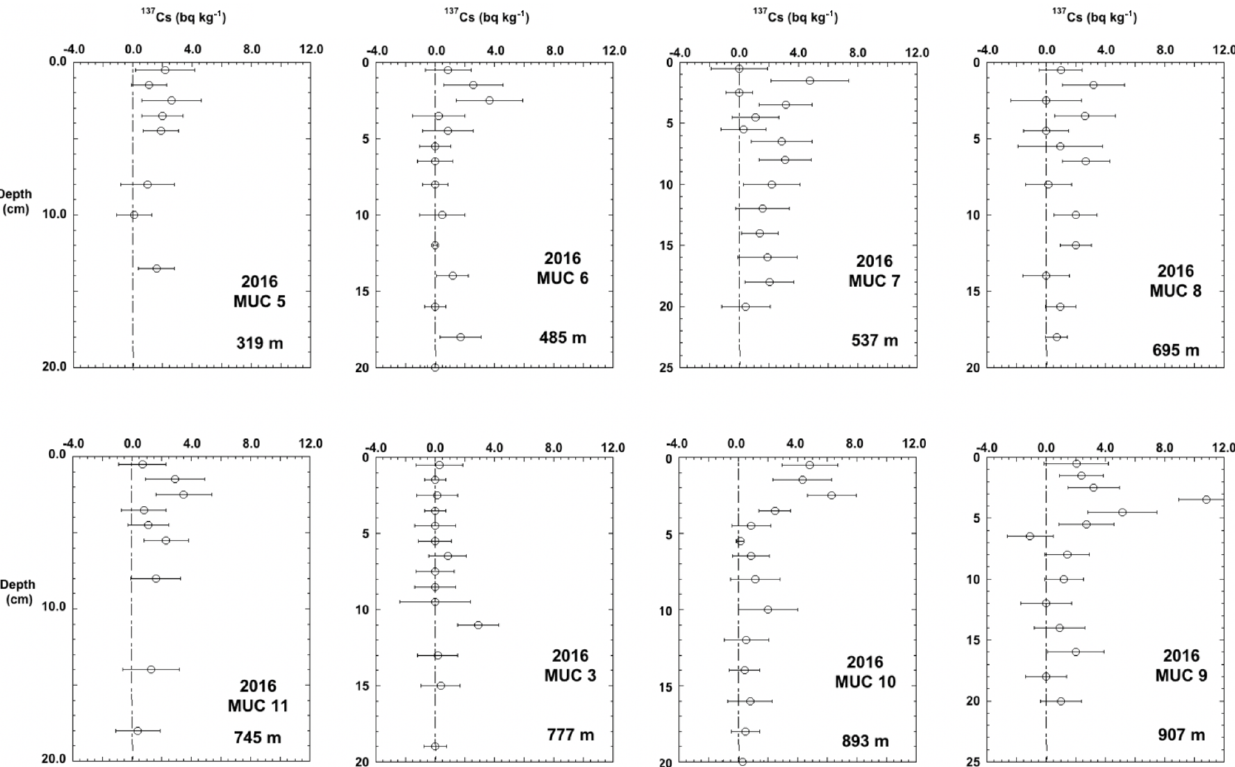
Figure 8. Eight multicores sampled for 137 Cs in the Santa Monica Basin. MUC 9 and MUC 10 were the only cores with a clear 137 Cs peak.